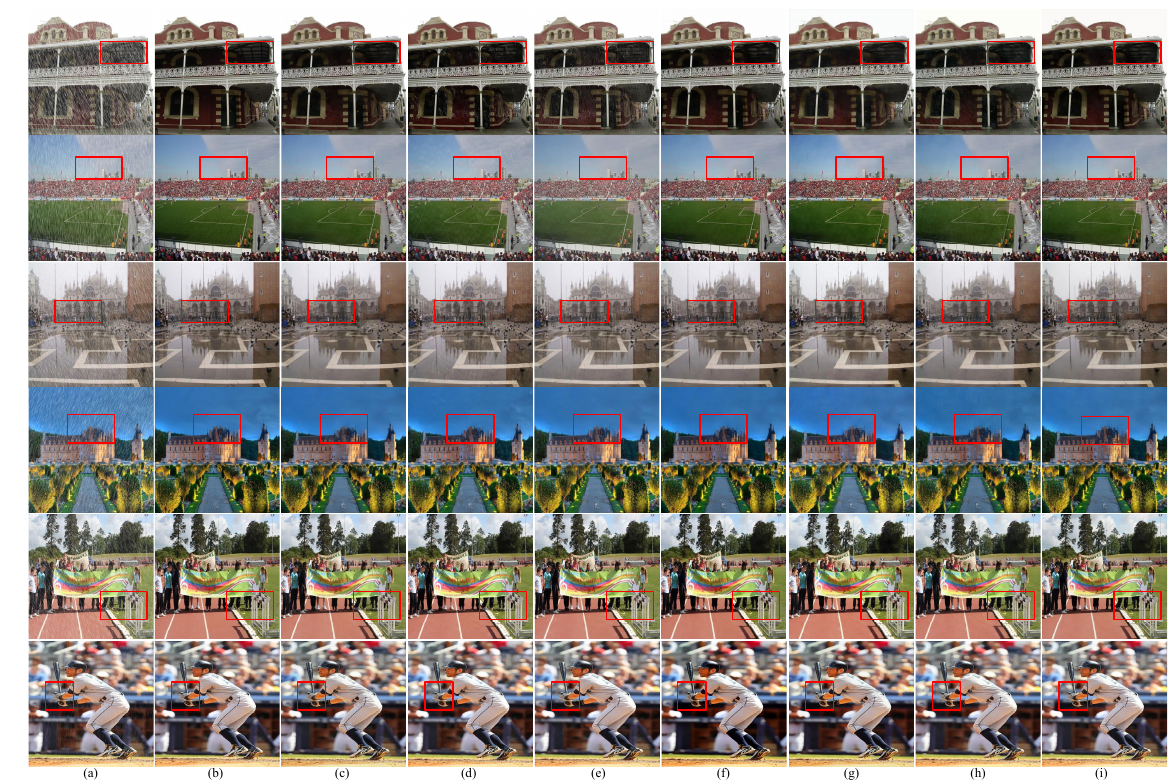
Figure 8. The visualization results by comparing SOTA methods from the synthetic dataset Test1200 . ( a ) Rainy image. ( b ) Ground-truth. ( c – g ) Results from RESCAN [12], MPRNet [16], PCNet [17], ReMAEN [32], DID-MDN [40]. ( h ) Deraining result from CR stage of our method. ( i ) Deraining result from RR stage of our method. Please zoom in on the red region to see clearly.